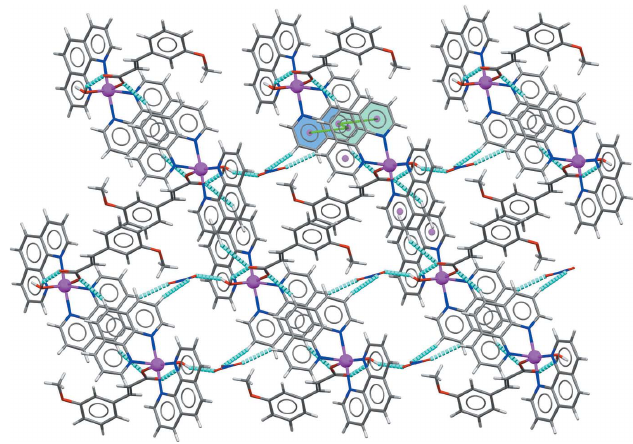
Figure 3 Crystal packing of the title compound showing the layers parallel to the bc plane formed by the (cid:2) – (cid:2) stacking interactions between the pyridyl rings of the 1,10-phenanthroline units (blue and cyan). Hydrogen bonds are shown by dashed cyan lines.